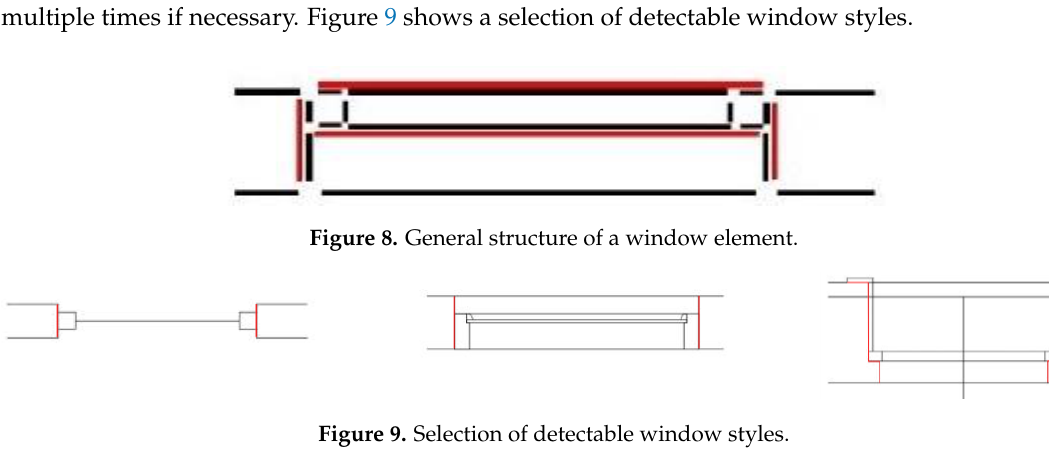
Figure 9. Selection of detectable window styles.